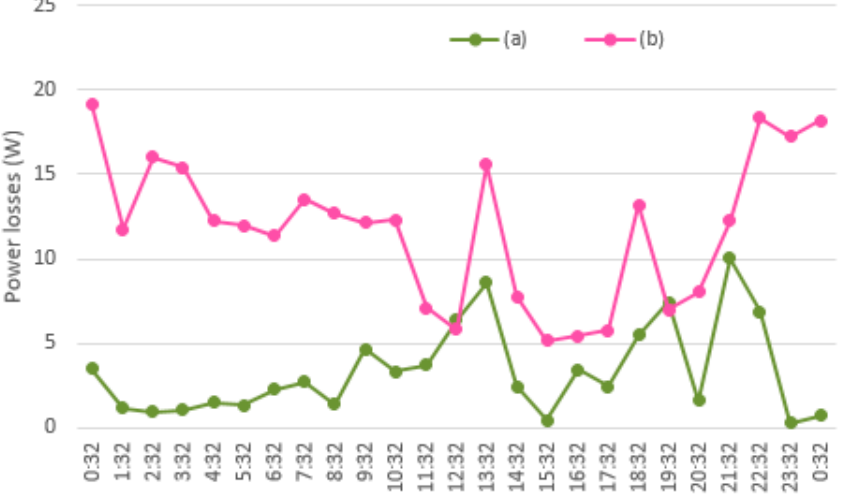
Figure 8. Transformer power losses, in working days, caused by (a) unbalanced currents ( P cu ) and (b) distorted currents ( P ch ).